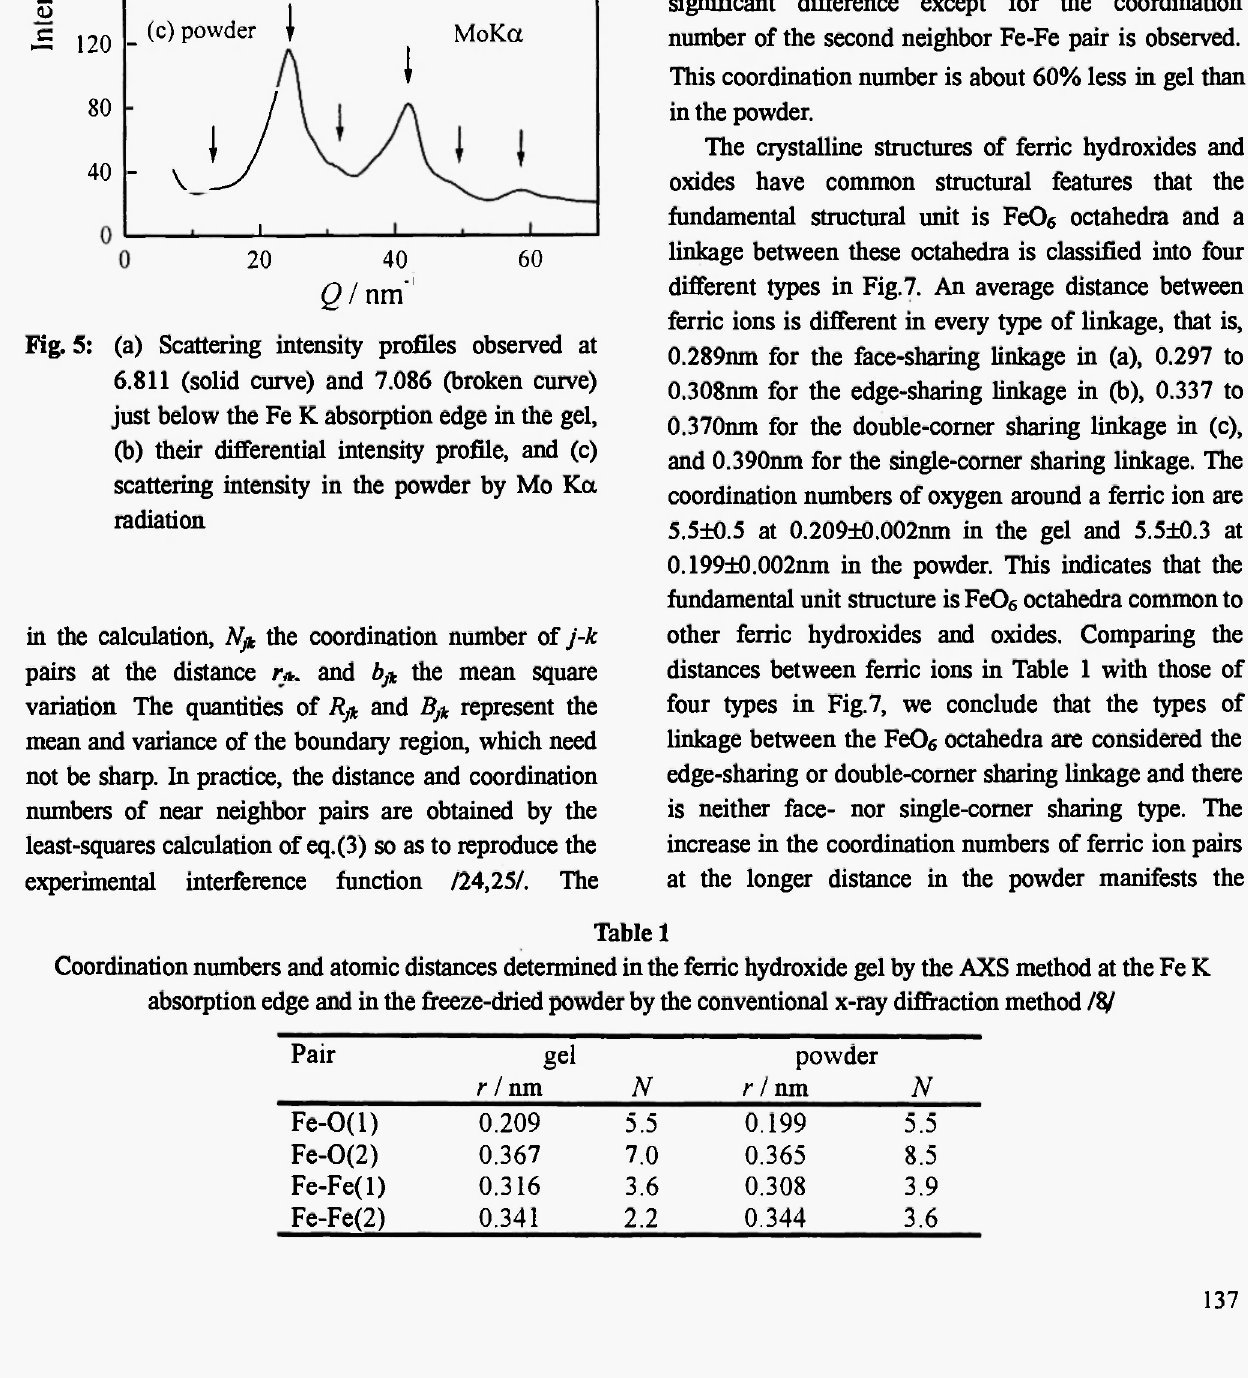
Fig. 5: (a) Scattering intensity profiles observed at 6.811 (solid curve) and 7.086 (broken curve) just below the Fe Κ absorption edge in the gel, (b) their differential intensity profile, and (c) scattering intensity in the powder by Mo Κα radiation